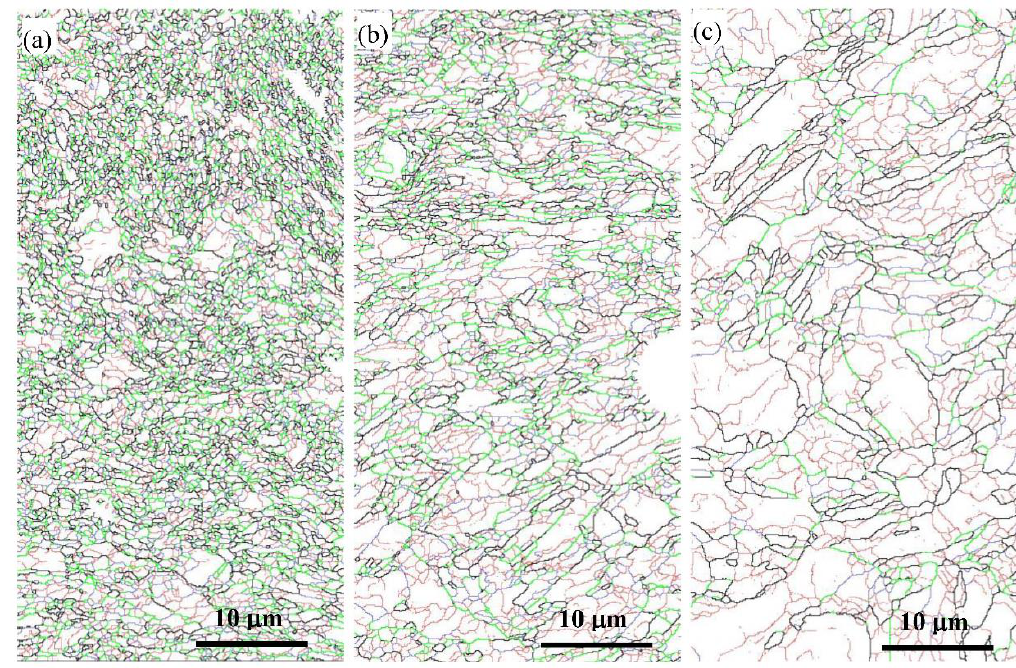
Figure 6. Boundary maps of the reduced activation steel after SMAT (corresponding to Figure 5): ( a ) The ultrafine grain zone, ( b ) the transition zone and ( c ) the deformed zone.